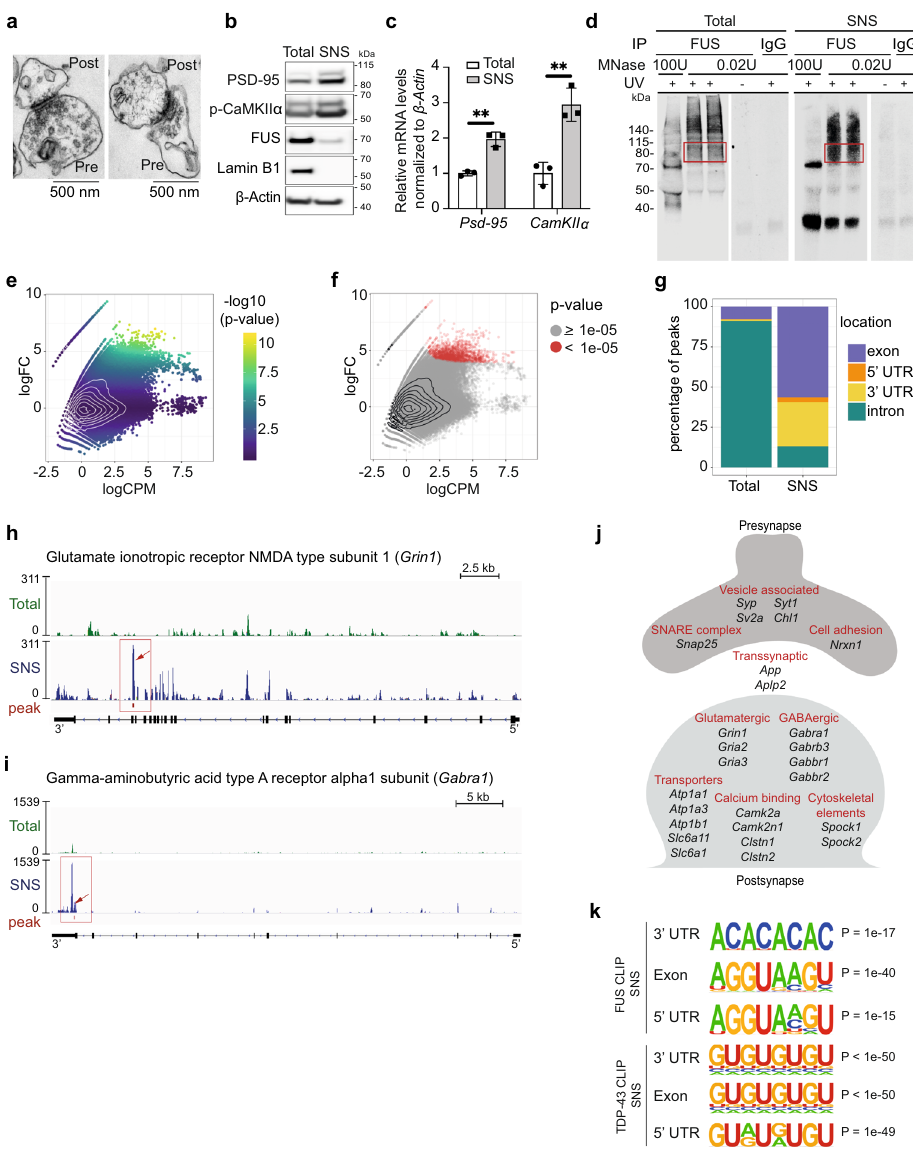
Fig. 2 CLIP-seq on cortical synaptoneurosomes identi fi ed FUS-associated pre- and postsynaptic RNAs. a Electron microscopic images of synaptoneurosomes (SNS) from mouse cortex showing intact pre- and postsynaptic compartments. n = 2, independent experiments. b Western blot of synaptic proteins (postsynaptic density protein (PSD95), phospho-calcium/calmodulin-dependent kinase II α (p-CamKII)), nuclear protein (Lamin B1), and Fused in sarcoma (FUS) in total cortex and synaptoneurosomes. n = 6 biological replicates. Source data are provided as a Source Data fi le. c qPCR shows enrichment of PSD95 ( p -value = 0.0015), and CamKII mRNAs ( p -value = 0.0040) in synaptoneurosomes compared to the total cortex. Bar graphs represent mean ± SD. Each dot represents total and SNS samples prepared from three independent mice. n = 3, ** p < 0.01, two-tailed, unpaired t -test. d Autoradiograph of FUS-RNA complexes immunoprecipitated from total cortex and synaptoneurosomes and trimmed by different concentrations of micrococcal nuclease (MNase). The red box indicates the excised part used for preparing CLIP libraries. Cortices from 200 mice were used to prepare synaptoneurosomes and two mice for the total cortex sample. Due to the necessity of this signi fi cant upscaling, library preparation and sequencing was not repeated ( n = 1). However, immunoprecipitation and autoradiograph has been repeated several times to con fi rm reproducibility. e MA-plot of CLIPper peaks predicted in the synaptoneurosome CLIP-seq sample. logCPM is the average log2CPM of each peak in the total cortex and synaptoneurosome sample and logFC is the log2 fold-change between the number of reads in the SNS and total cortex sample. The row of points in the upper left corner are peaks with zero reads in the total cortex sample. P-values shown in e , f are computed by likelihood-ration test and unadjusted for multiple comparisons. f Same MA-plot as in e showing the selected, synaptoneurosome-speci fi c peaks ( p -value cutoff of 1e-05) in red. g Bar plot with the percentage of synaptoneurosome and total cortex-speci fi c peaks located in exons, 5 ′ UTRs, 3 ′ UTRs or introns. FUS binding in Grin1 ( h ) , Gabra1 ( i ) in total cortex (green), and SNS (blue). j Schematic with the cellular localization and function of some of the selected FUS targets. k Predicted sequence motifs (HOMER) in windows of size 41 centered on the position with maximum coverage in each peak. Each set of target sequences has a corresponding background set with 200,000 sequences without any CLIP-seq read coverage (they are not bound by FUS/TDP-43). We note that these are all FUS motifs that were marked as true positives by HOMER and that occur in more than 3% of the target sequences, while the top motif is shown for TDP-43. P -values are reported by HOMER (one-sided hypergeometric